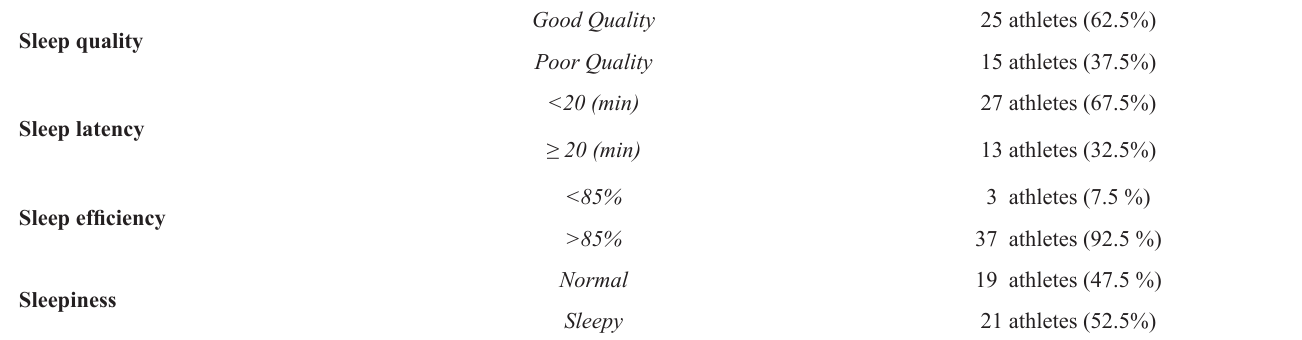
2-3 times/month, 1.9% 3-6 times/week, 5.6% always), muscle cramps (20.4% rarely, 3.7% 1-2 times/week) and leg movement (14.8% rarely, 5.6% 1-2 times/week, 5.6% 2-3 times/month, 9.3%